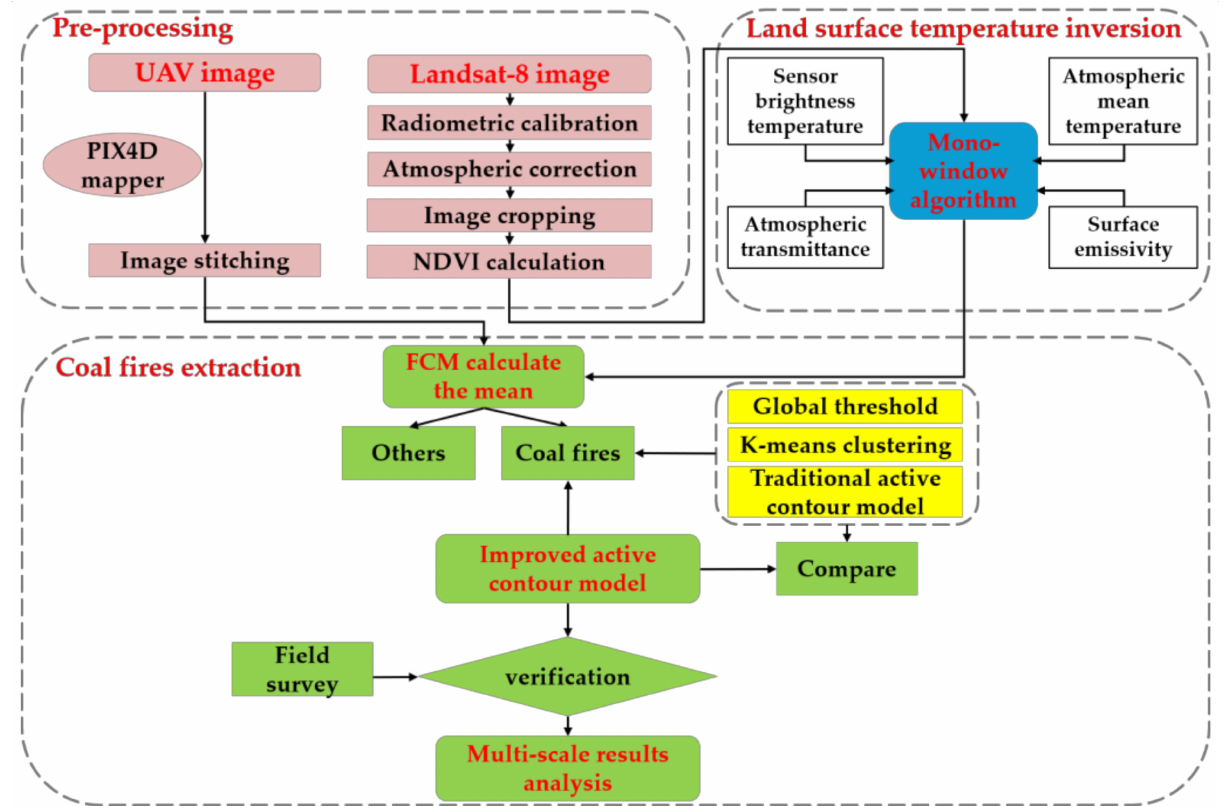
Figure 3. Flow chart of the coarse-to-fine coal fire detection